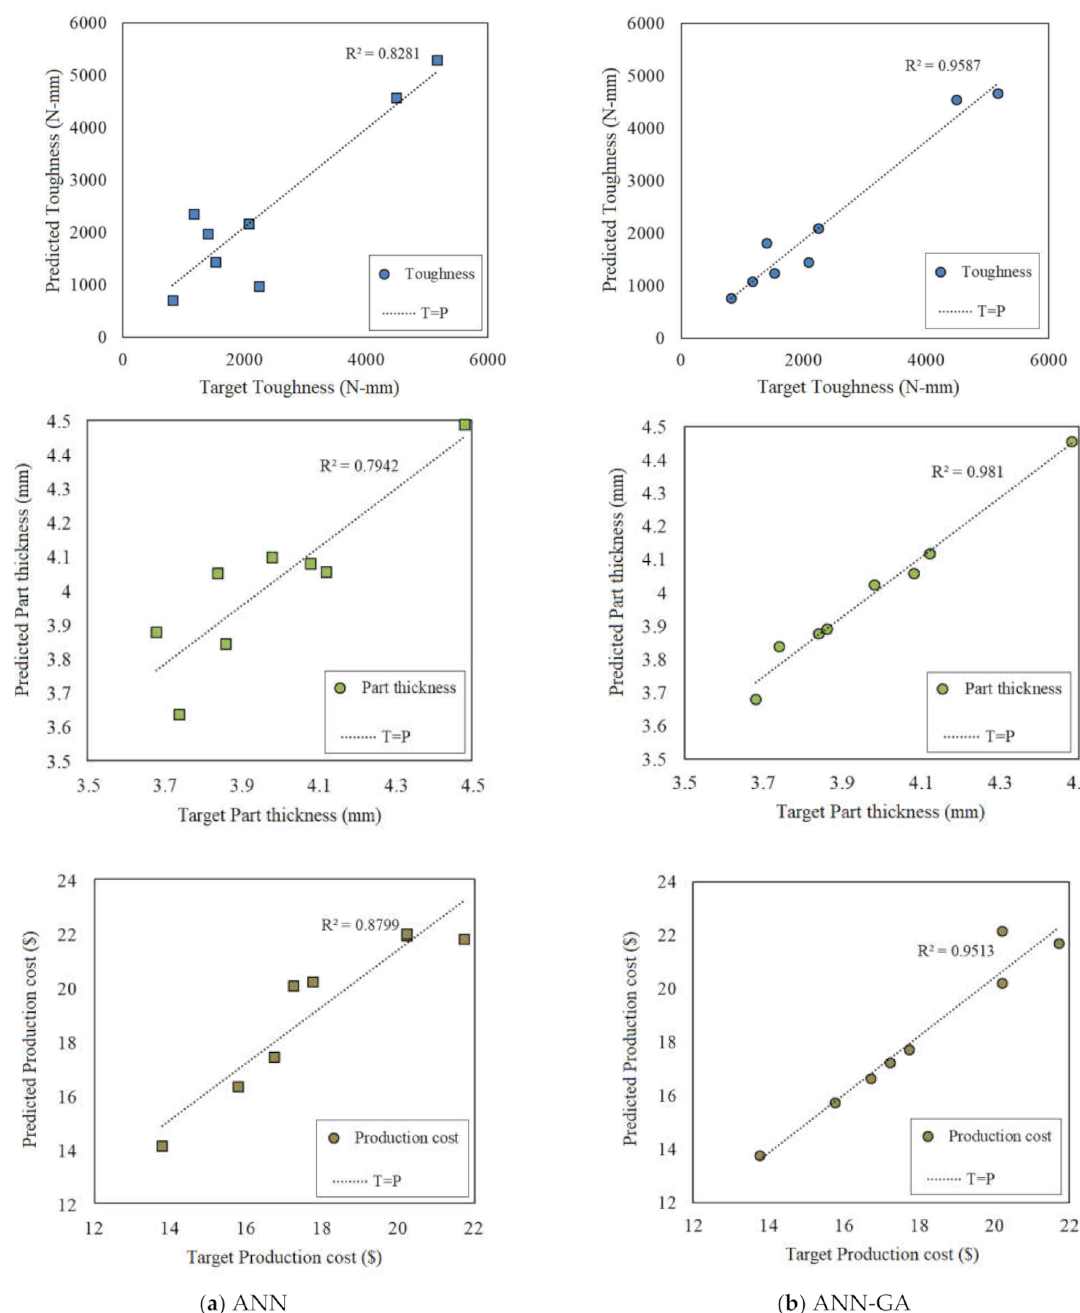
Figure 12. Plot diagrams for the testing phase. ( a ) Single ANN-GA and ( b ) hybrid